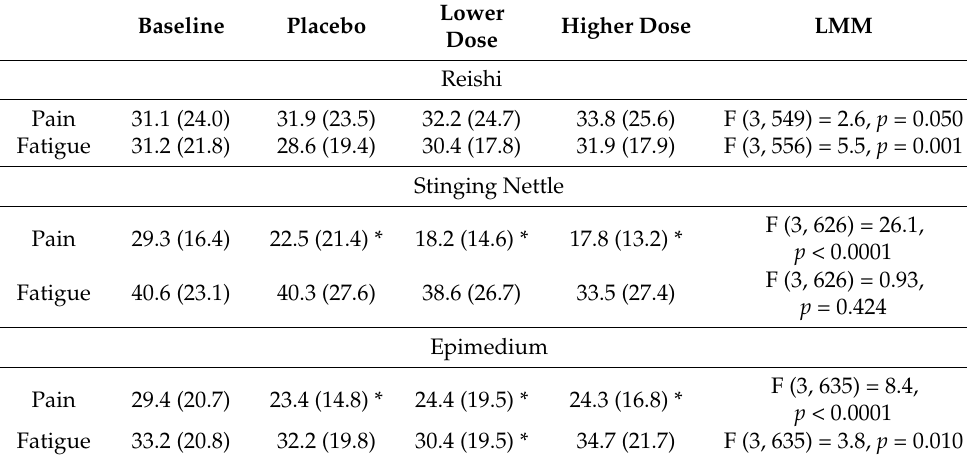
Table 1. Means (and standard deviations) and linear mixed model (LMM) results for the secondary outcomes of self-reported pain and fatigue. Results are presented separately for reishi, stinging nettle, and